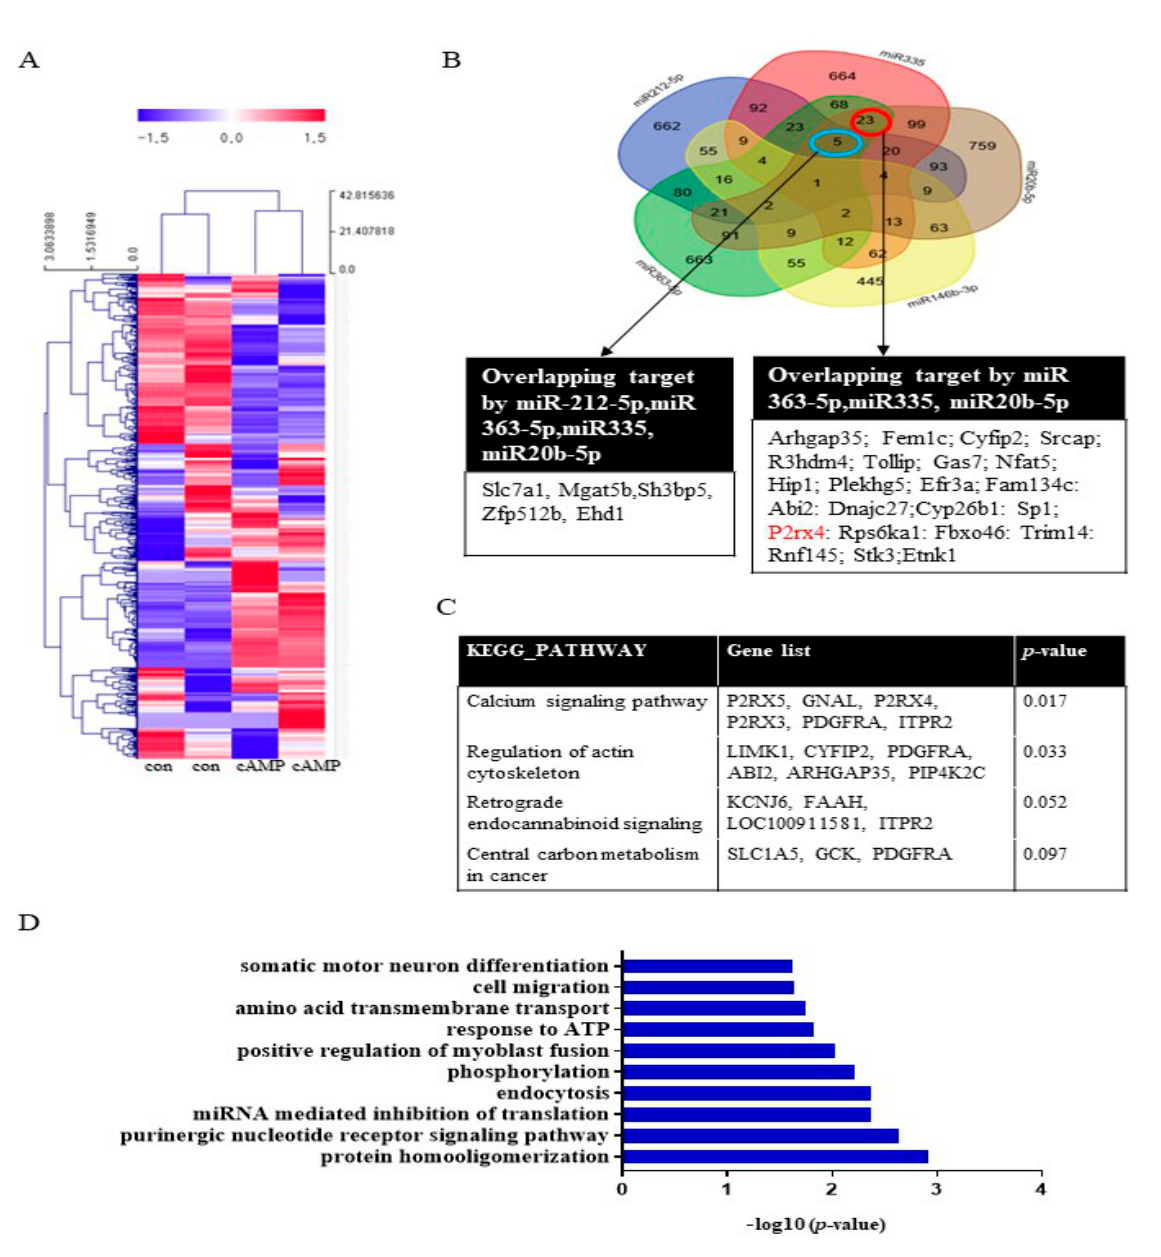
Figure 1. The biological functions of miRNAs in cAMP-induced Schwann cells. ( A ) miRNA expression in Schwann cells after cAMP treatment based on microarray analysis. Red indicates upregulated miRNAs; blue indicates downregulated miRNAs. n = 2 per sample. The heat map visualizes the hierarchical clustering of differentially expressed miRNAs (log2FC) from cAMP-treated primary Schwann cells compared with controls, according to the indicated color scale. ( B ) A Venn diagram was used to identify overlapping targets of five upregulated miRNAs (miR212-5p, miR335, miR20b-5p, miR146b-3p, and miR363-5p). KEGG pathways ( C ) and GO terms ( D ) for the target genes are shown.